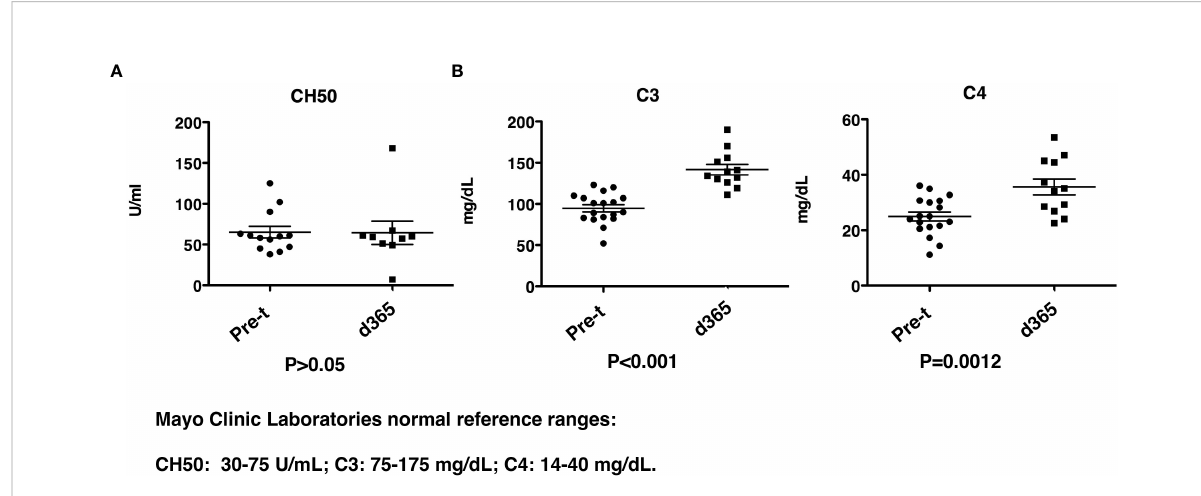
FIGURE 9 Complement levels after HISCT. (A) CH50 levels are shown at pre-transplantation and at day 365. (B) C3 and C4 levels are shown at pre- transplantation and at day 365. Pre-t, pre-transplant; d, day; HISCT, haploidentical stem cell